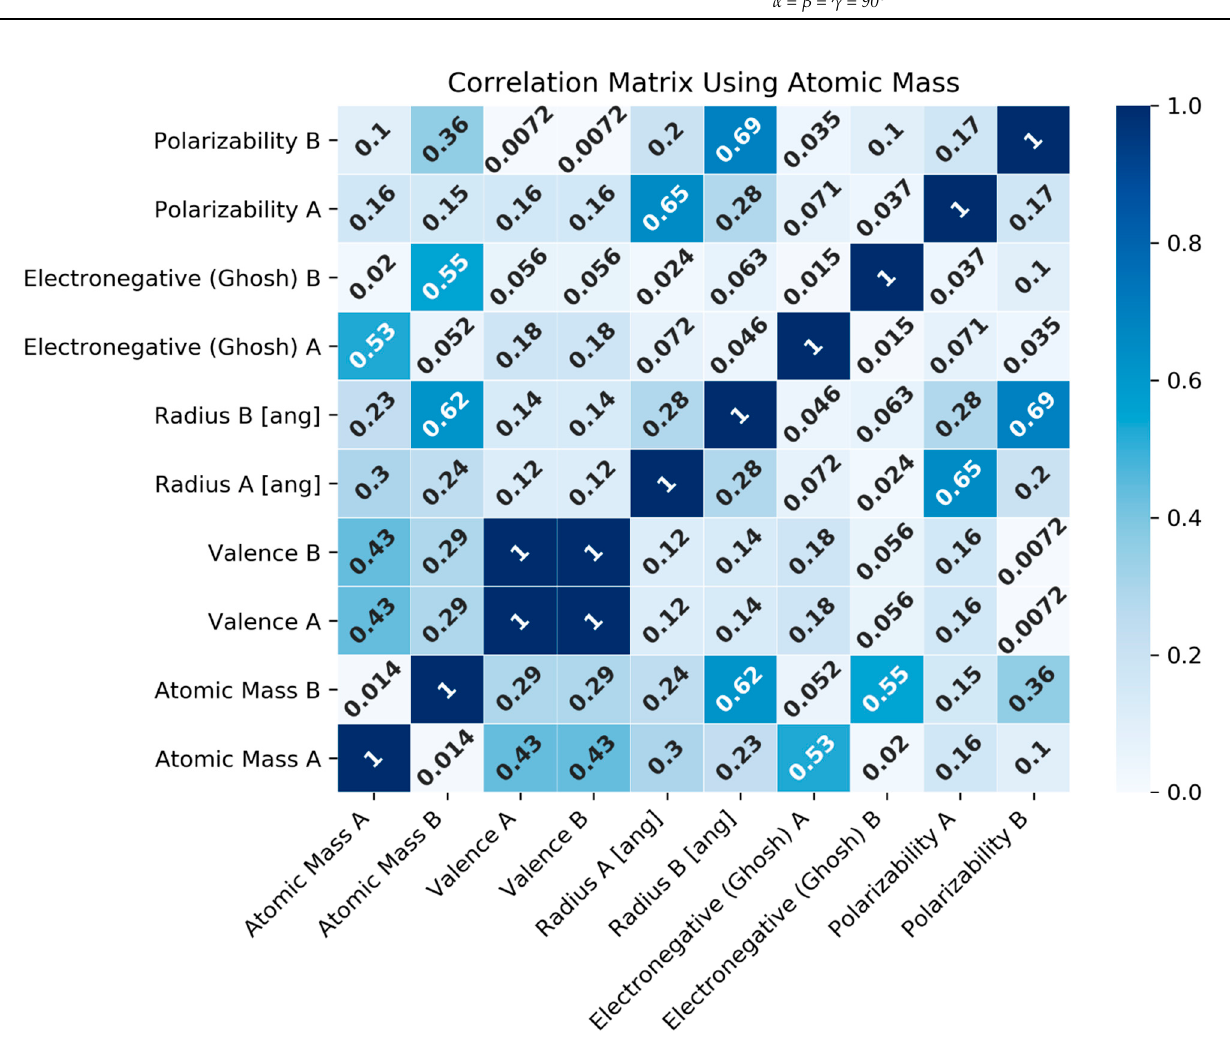
Figure 4. Pearson correlation matrixes for the crystal structure prediction model.